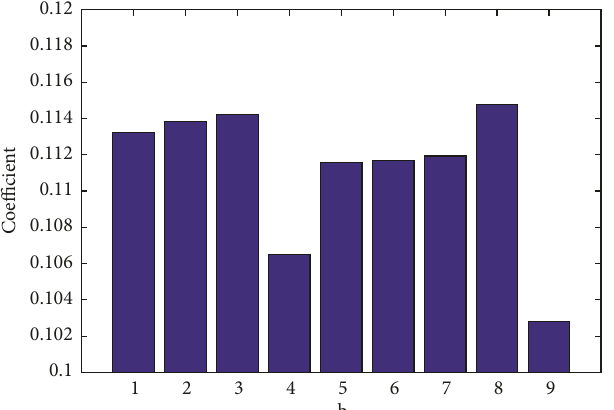
Figure 11: The histogram of the contribution coefficient of each local